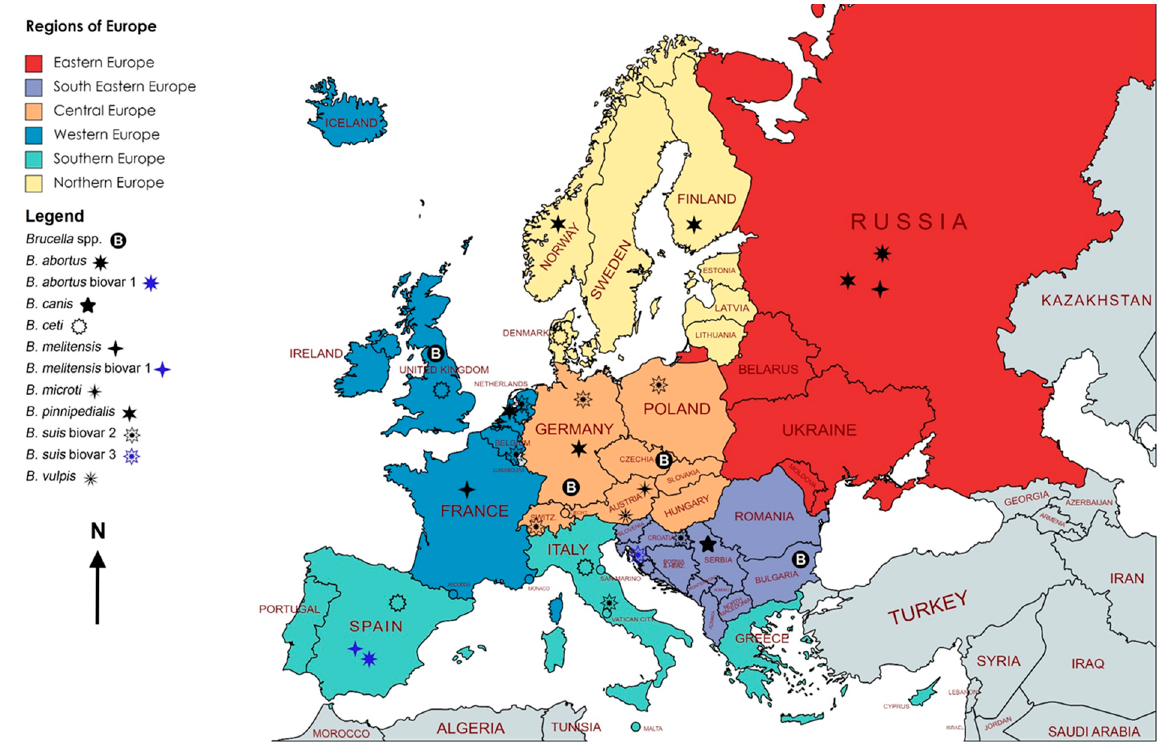
Figure 2. Map showing Brucella species and biovars isolated from European wildlife.